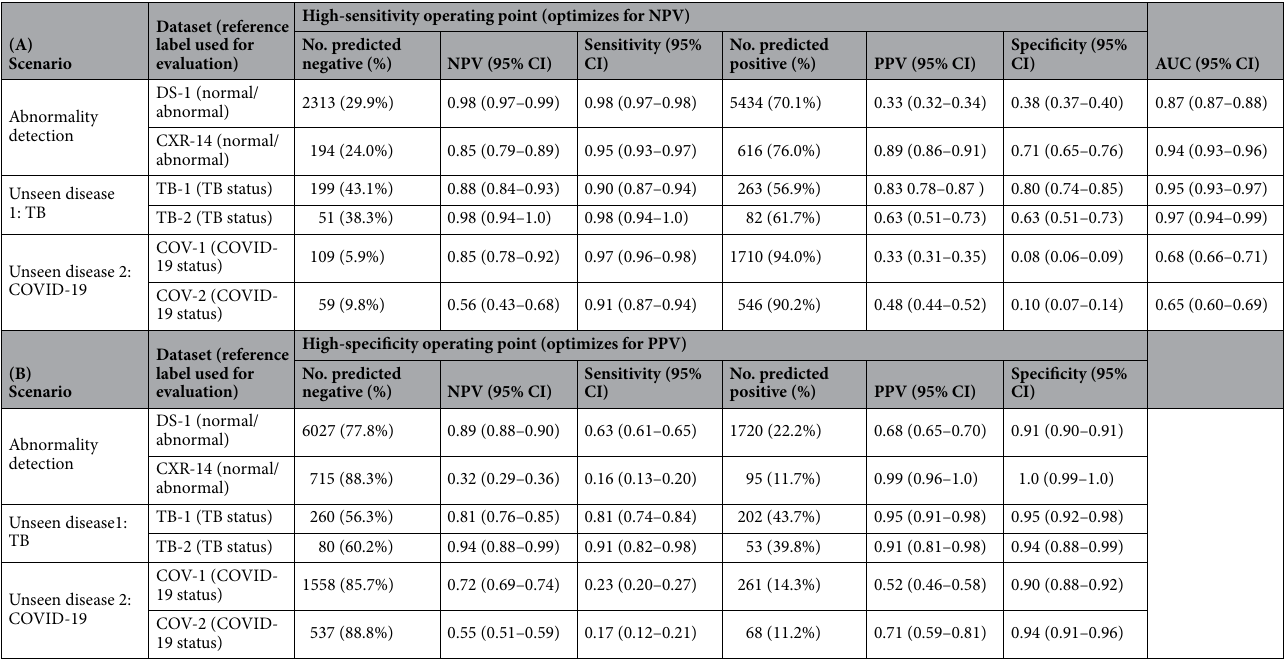
Table 2. Quantitative evaluation of DLS in distinguishing normal versus abnormal CXRs across 6 datasets. (A) The DLS’s performance with the high-sensitivity operating point. (B) The DLS’s performance with the high-specificity operating point. The AUC is independent of the operating point and is identical to that in